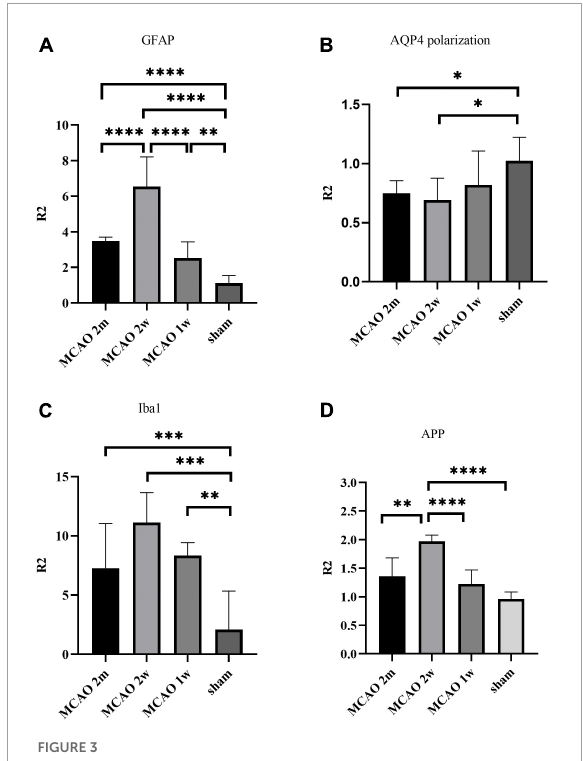
FIGURE3 Quantitative analysis results of ratio (R2) in the thalamus VPN. The astrocyte and microglial activation (A,C) and the APP deposition (D) in the ipsilateral thalamus VPN were obvious, especially at the 2nd week after MCAO. The AQP4 polarization (B) in the ipsilateral thalamus VPN decreased, especially at the 2nd week and the 2nd month after MCAO. ∗ P < 0.05; ∗∗ P < 0.01; ∗∗∗ P < 0.001; ∗∗∗∗ P < 0.0001. VPN, ventroposterior nucleus; APP, Beta-amyloid precursor protein; MCAO, middle cerebral artery occlusion; AQP4, aquaporin